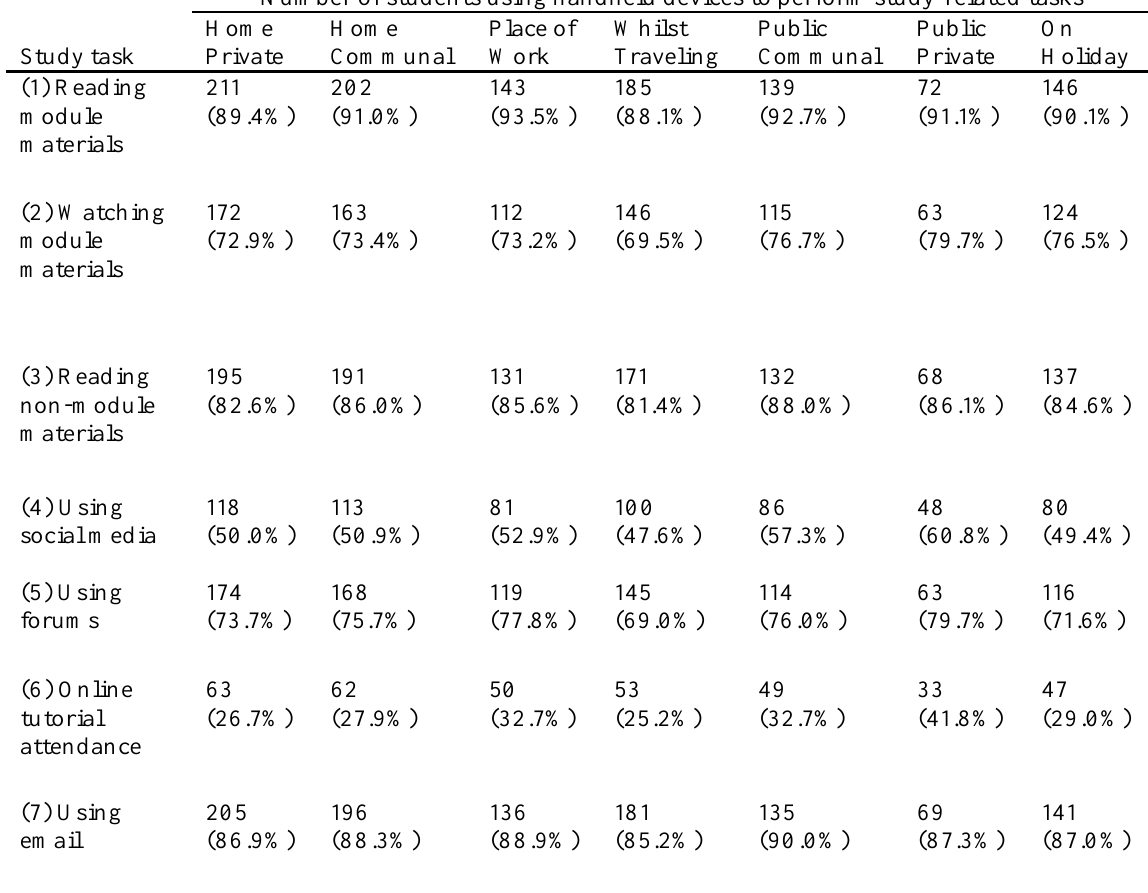
Use of Handheld Devices for Study-Related Learning Tasks in Seven Study Places. Number of students using handheld devices to perform study-related tasks Study